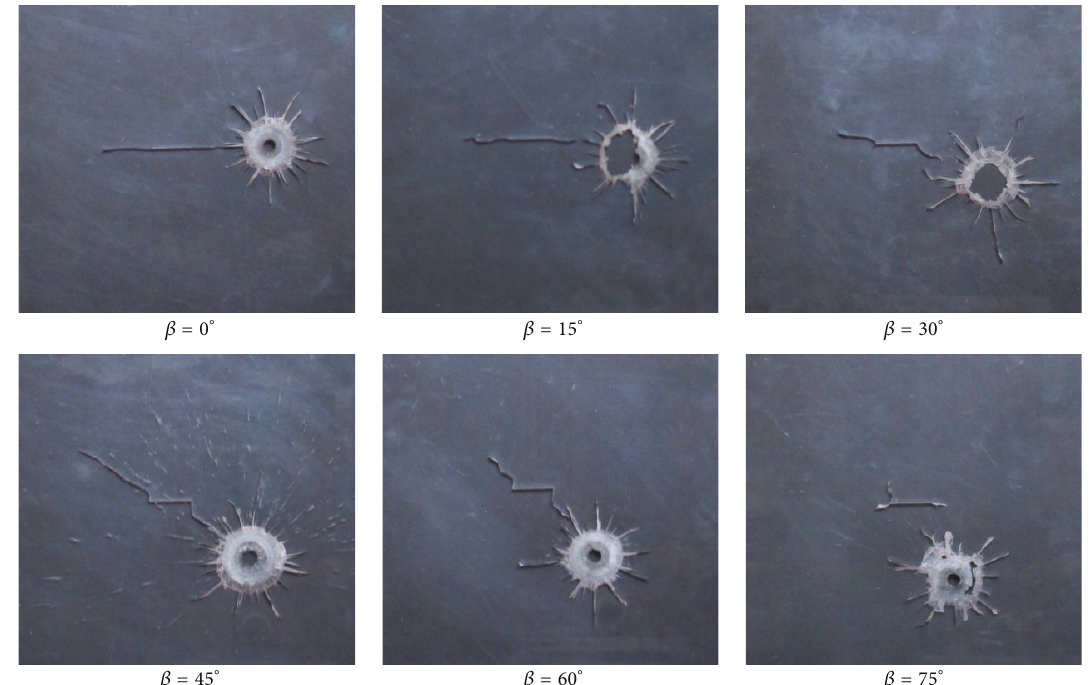
Figure 10: Experiment results of different incident angles in